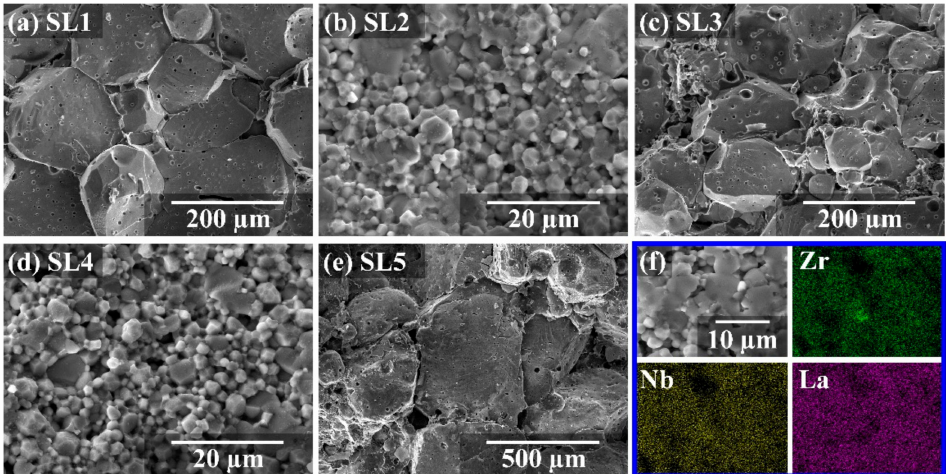
Figure 6. ( a – e ) SEM images of the cross-sectional microstructures of the ceramics that were sintered by di ff erent particles sizes under di ff erent sintering conditions and ( f ) EDS mapping of LLZNO ceramics section sintered at 1200 ◦ C for 30 min.